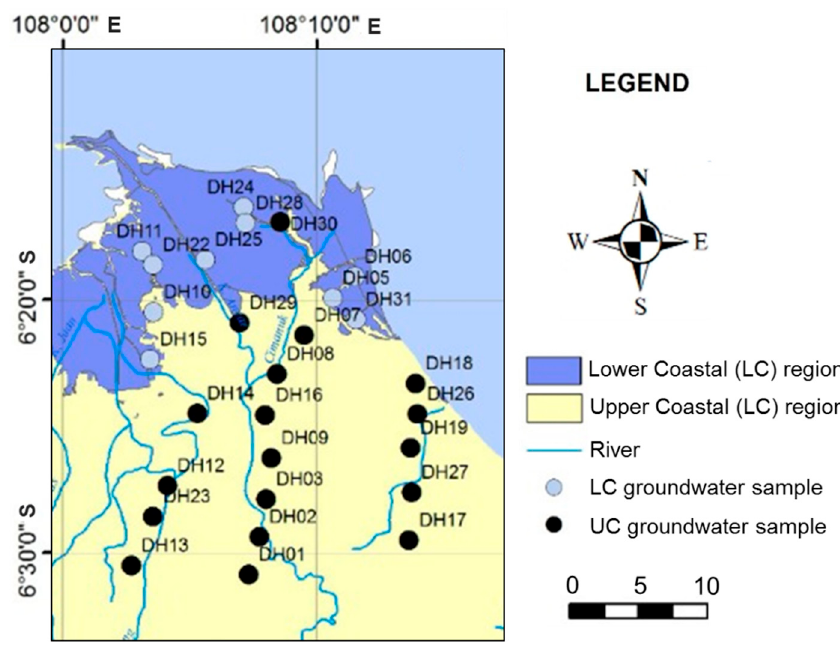
Figure 2. Sampling points in the study site.